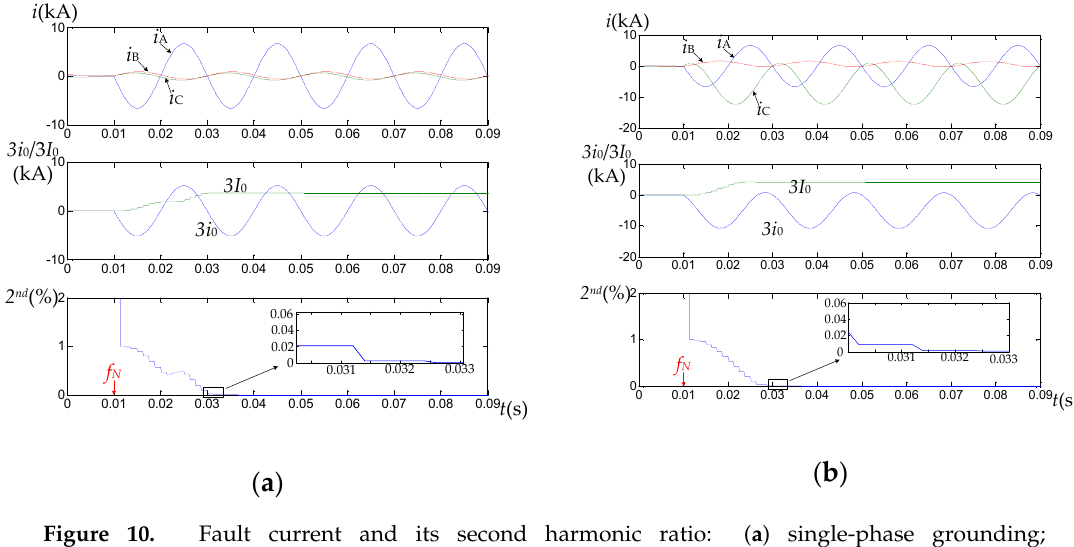
Figure 10. Fault current and its second harmonic ratio: ( a ) single-phase grounding; ( b ) two-phase grounding.